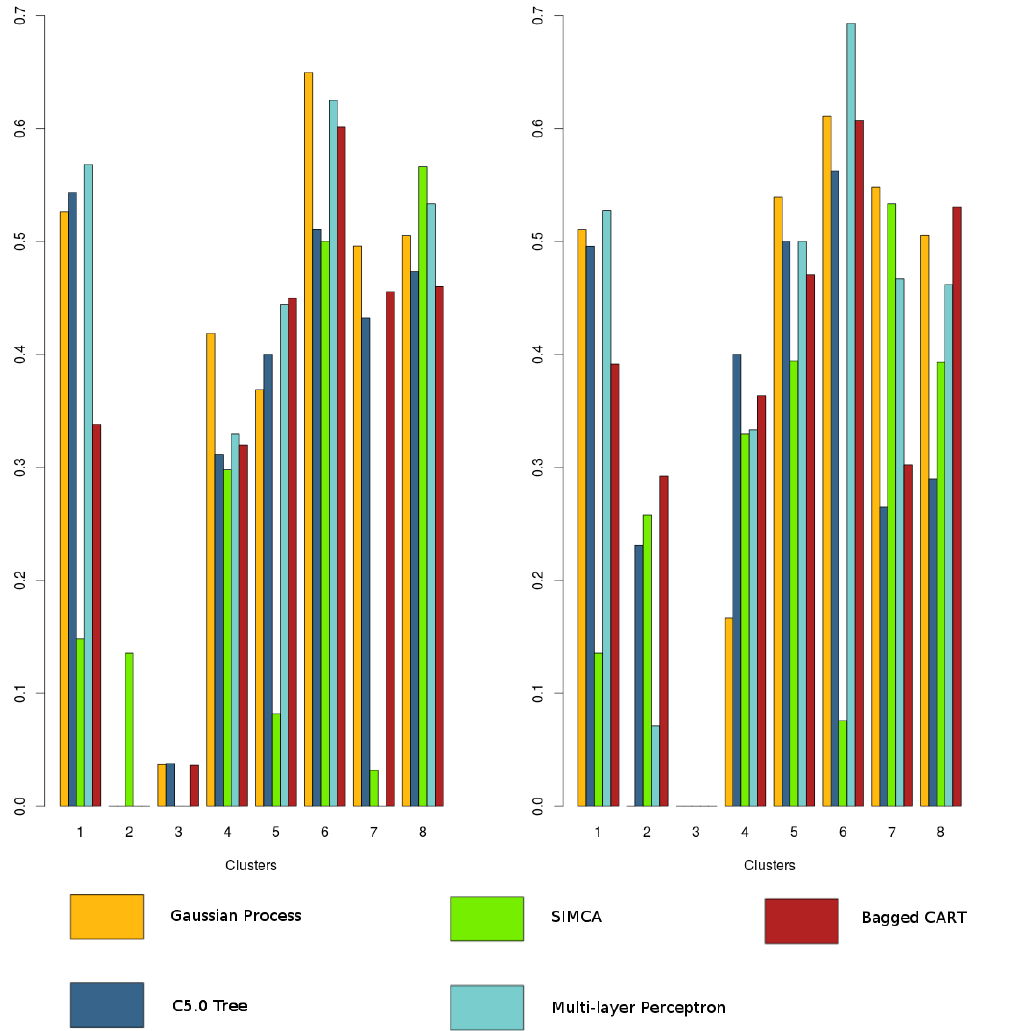
Figure 6. Classification results of automatically-clustered data in Building